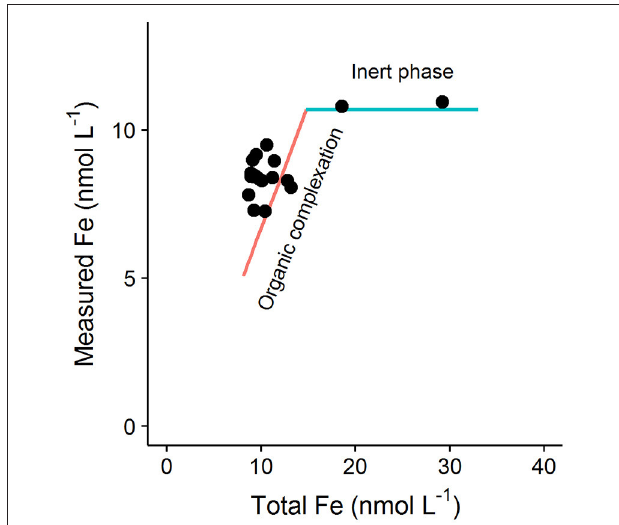
FIGURE 5 | Schematic showing the theoretical change in the concentration of Fe measured for a given titration point (i.e., same added metal concentration) across a dataset if the total Fe concentrations (DFe plus added Fe) vary, but the binding site composition and concentration stay the same. The red line shows the expected behavior for a system in equilibrium, i.e., if DFe is labile to the added ligand and a reaction occurs. If the measured iron concentration fails to increase despite increasing total Fe (blue line) then this is indicative of an inert Fe fraction (e.g., aged oxyhydroxides). Black data points are equivalent titration points (black points) obtained by Avendaño et al. (2016) (8 nmol L − 1 iron